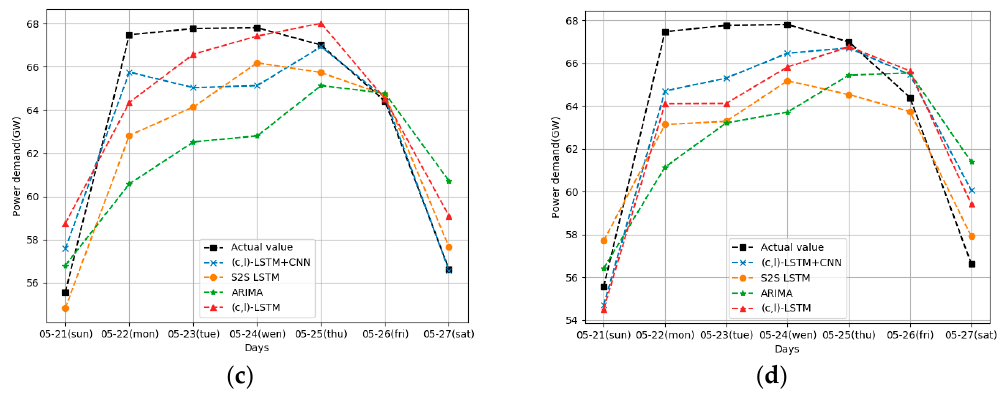
Figure 11. Forecasting performances on d 2 : ( a ) spring; ( b ) summer; ( c ) autumn; ( d ) winter.